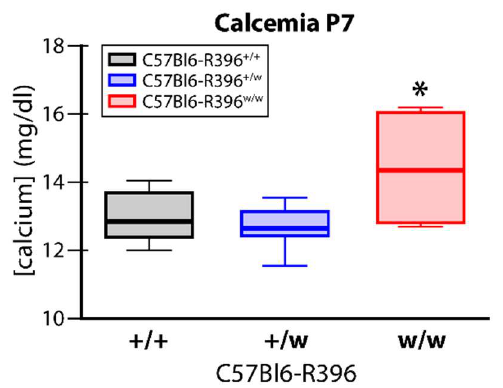
Figure 2. Serum calcium levels in C57Bl6-R396 littermates at postnatal day 7. Total serum calcium was measured using an automated analyzer. +/+, C57Bl6-R396 +/+ ; + /w, C57Bl6-R396 + /w ; w/w, C57Bl6-R396 w/w . *, p < 0.05 by one-way ANOVA and Dunnett’s post hoc test.